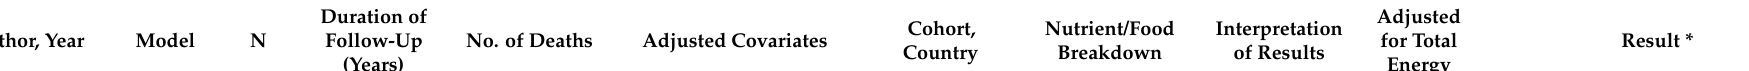
Table 3. List of recent past studies that examined the association of animal protein with all-cause mortality by substituting animal protein for other macronutrients in a healthy population at